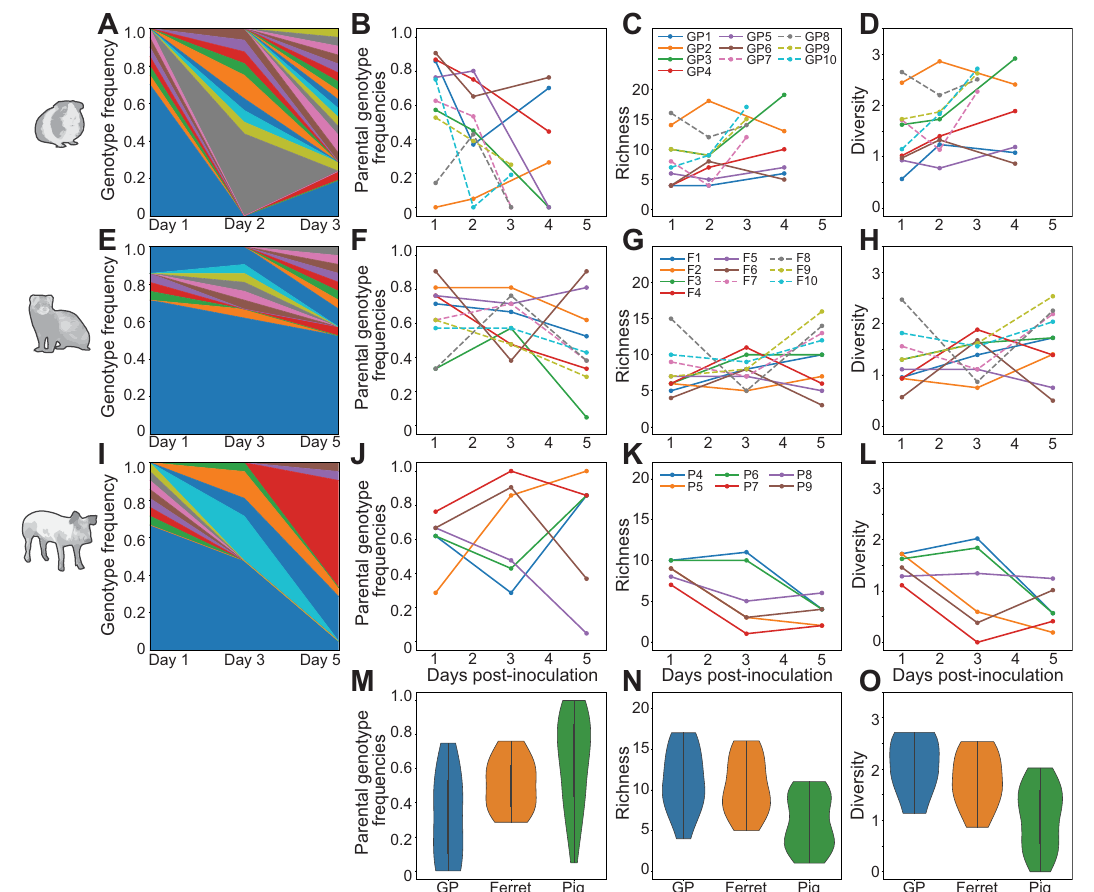
Fig. 1 | Viral genotypic diversity generated through reassortment in the mammalian nasal tract. Results from guinea pigs are shown in A – D , ferrets in E – H ,andswinein I – L .Stackedplots( A , E , I )showfrequenciesofuniquegenotypes detectedinonerepresentativeanimalovertime.BlueandorangerepresenttheWT and VAR parental genotypes, respectively. The frequency of both parental geno- typescombined( B , F , J ),richness( C , G , K ),andShannon – Weinerdiversity( D , H , L ) are each plotted as a function of time. Guinea pigs and ferrets inoculated at high dose (1×10 5 ID 50 ) and low dose (1×10 2 ID 50 ) are indicated with dashed and solid lines,respectively. The distribution ofparentalgenotype frequencies ( M ),richness ( N ), and diversity ( O ) across all time points in each species (guinea pigs n =12; ferrets n =12; swine n =18) is shown with violin plots. Data are presented as violin